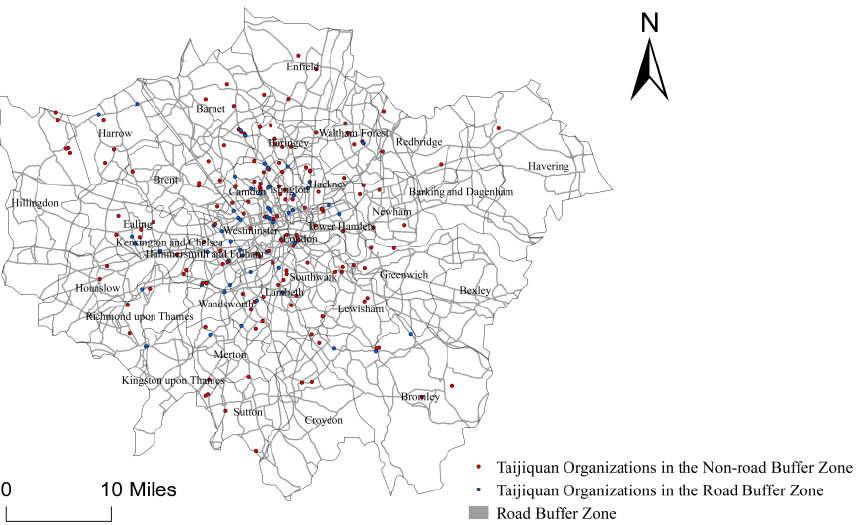
Figure 5. Main Traffic Route Map for the Spatial Distribution of Taijiquan Organizations in Lon- don.